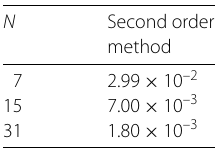
Table 8 The maximum absolute errors of Problem 2 from [30]